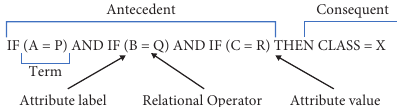
Figure 1: The structure of a generic classification rule. The example demonstrates the key components of a classification rule. The antecedent contains one or more attribute-value pairs connected by AND conjunction. The suggested class is shown in the consequent on the right side of the THEN